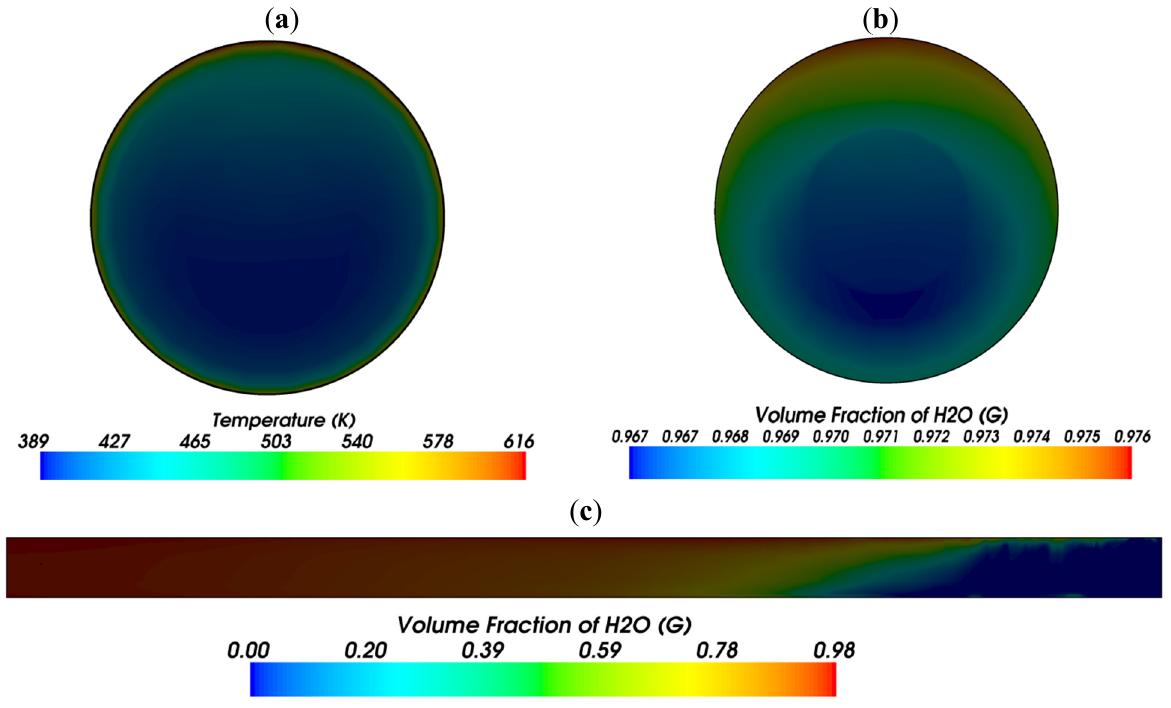
Figure 5. Steam outlet ( a ) temperature distribution; ( b ) volume fraction and ( c ) volume fraction at a cross sectional plane across the tube axis (not to scale) for a 0.01 m diameter tube with flow rate of 15 kg/h (0.0042 kg/s) at noon in